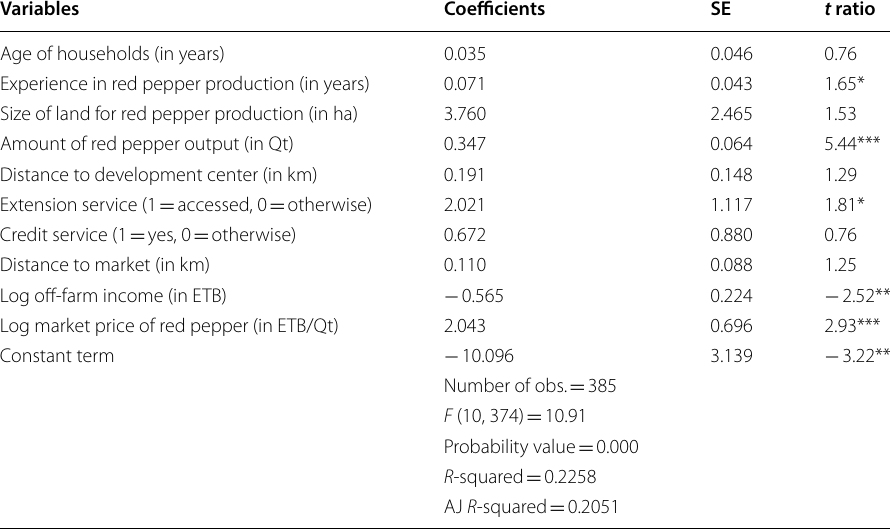
Table 3 Determinants of red pepper market surplus (OLS